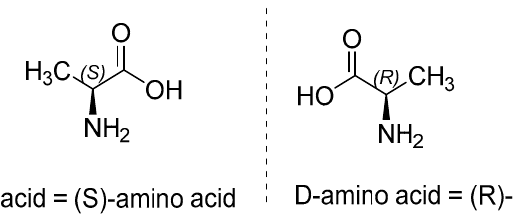
Figure 4. (S) and (R) ‐ enantiomers of an amino acid, representing its respective L and D ‐ enantiomers.